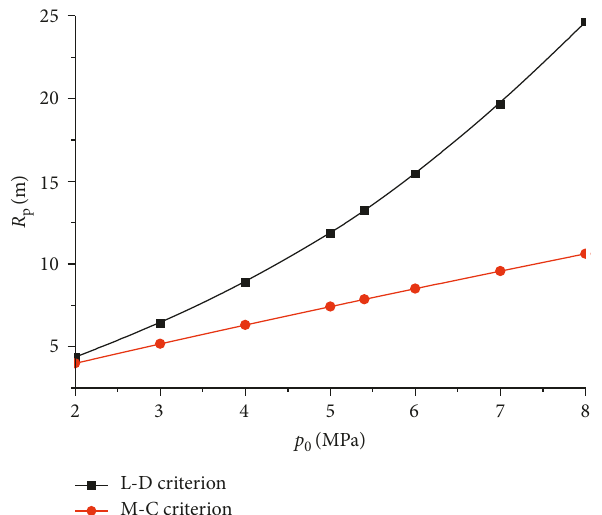
Figure 5: Relation curves between in situ stress and plastic zone radius.